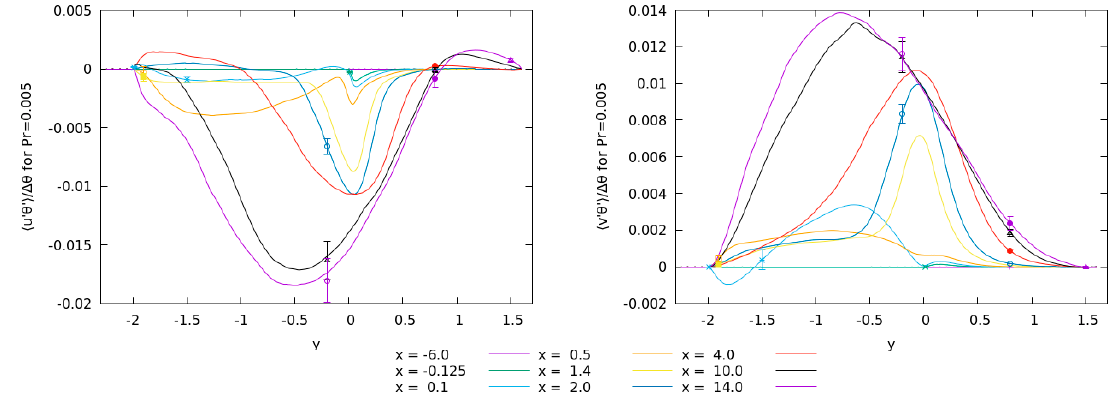
Figure 9. Profile of turbulent heat flux components for passive scalar with Pr = 0.005, together with values and uncertainties calculated in monitor points in the plane 𝑧 = 0 .